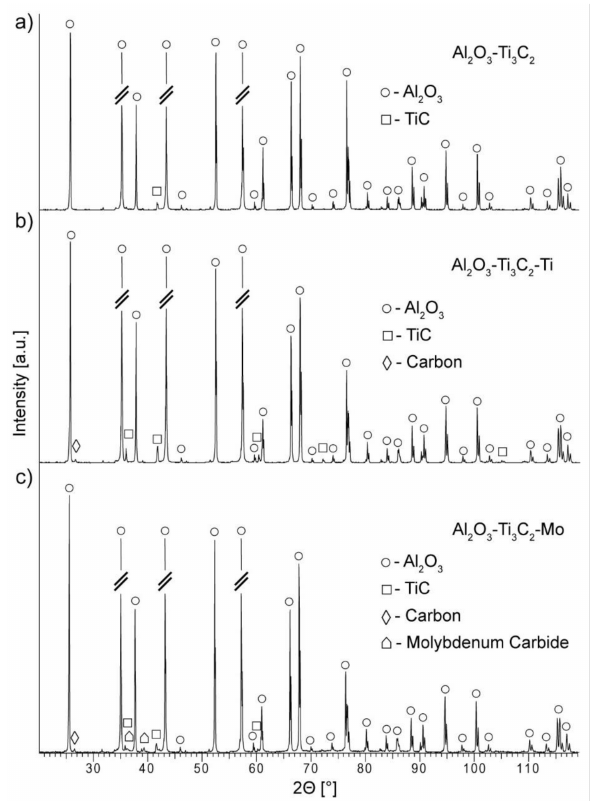
Figure 9. XRD patterns for composites with 2 wt.% of ( a ) Ti 3 C 2 , ( b ) Ti 3 C 2 -Ti, ( c ) Ti 3 C 2